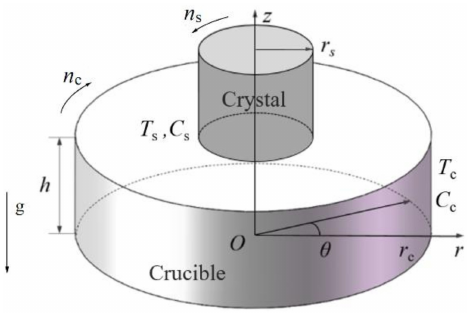
Figure 1. Physical